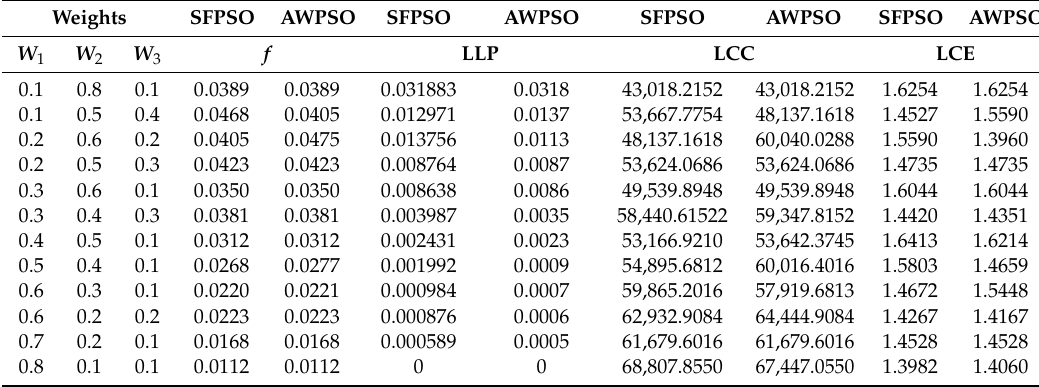
Table 5. Di ff erent weights sets and optimal performance of the SAPV